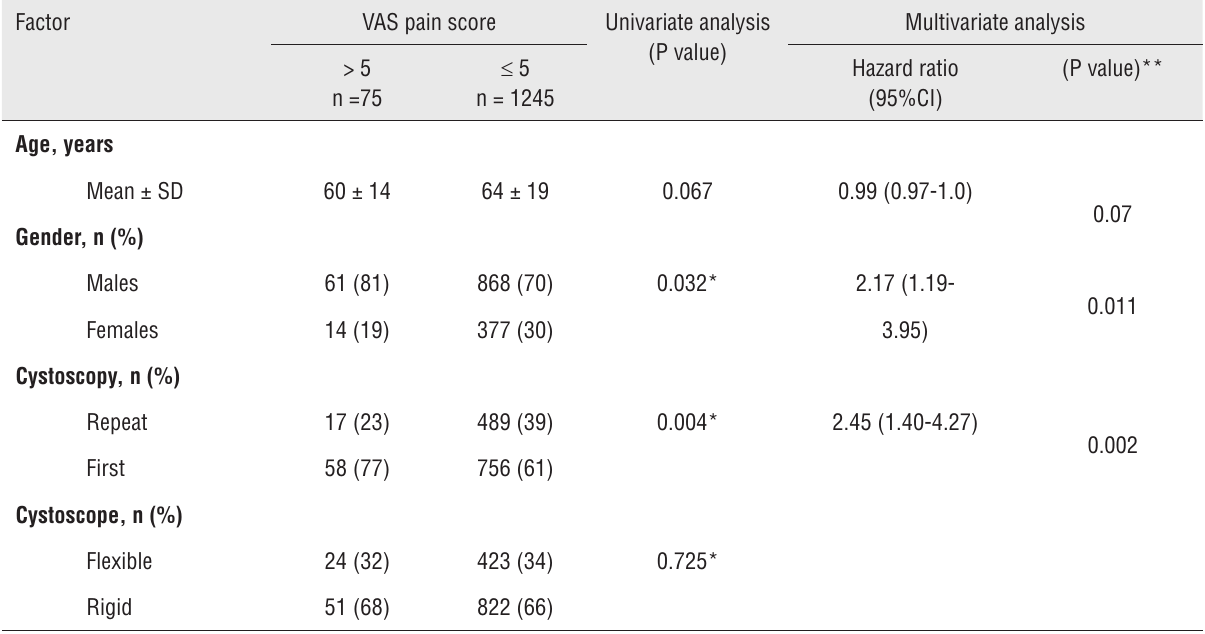
Table 2 - Predictors of pain during